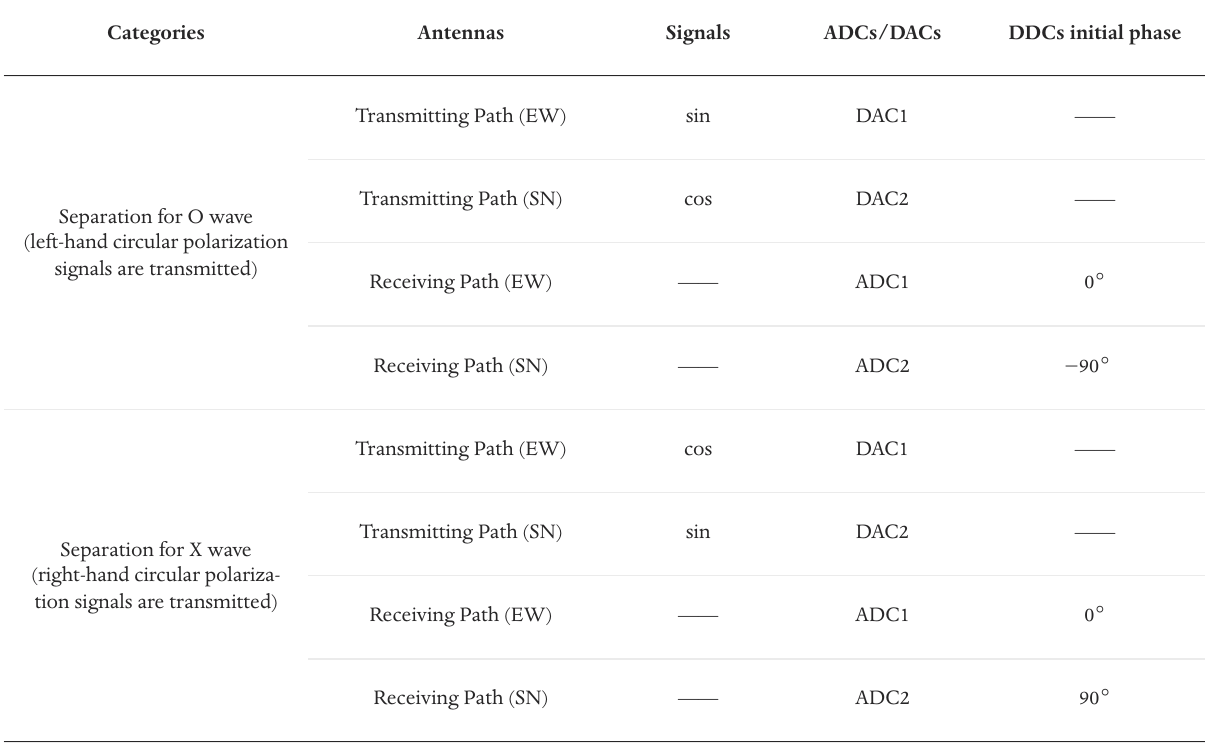
Table 2. The relationship within parts of ionosode for separation of O wave and X wave in